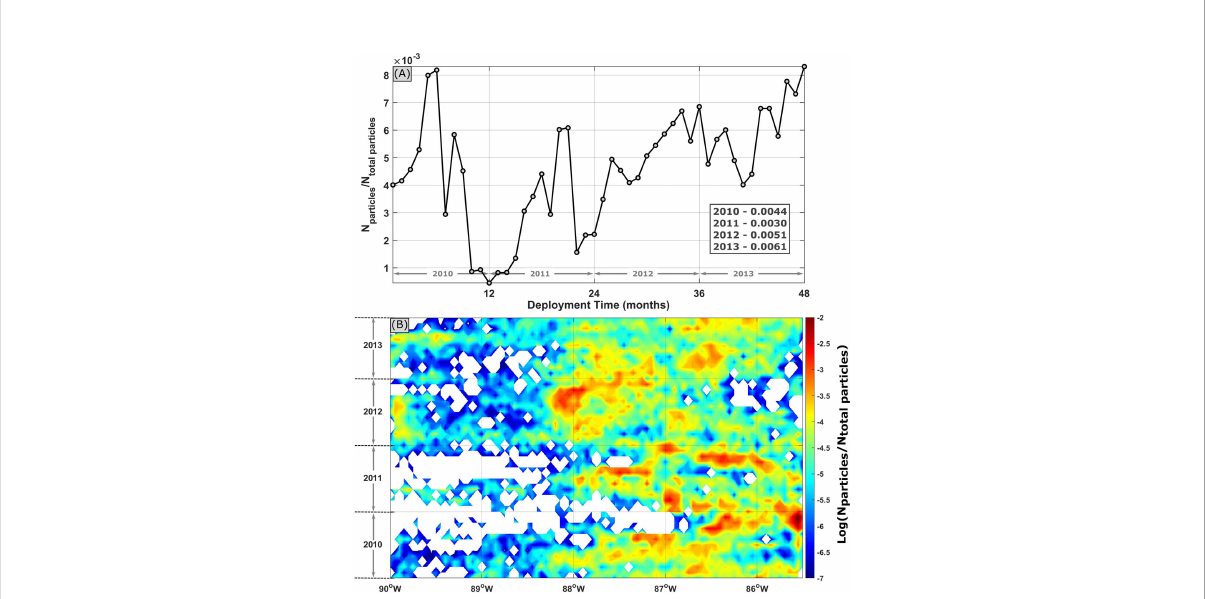
FIGURE 7 (A) Virtual particle density, normalized by the total number of virtual particles in the domain, moving south across 28°N in water depths greater than 1,500 m (de fi ned as 86.5°W – 89°W, the section of the red line at 28°N outlined in black in Figure 6), as a function of months from deployment. The inset box gives the mean for each year. (B) Virtual particle density, normalized by the total number of virtual particles in the domain, moving south across 28°N as a function of longitude and time, is represented on a log